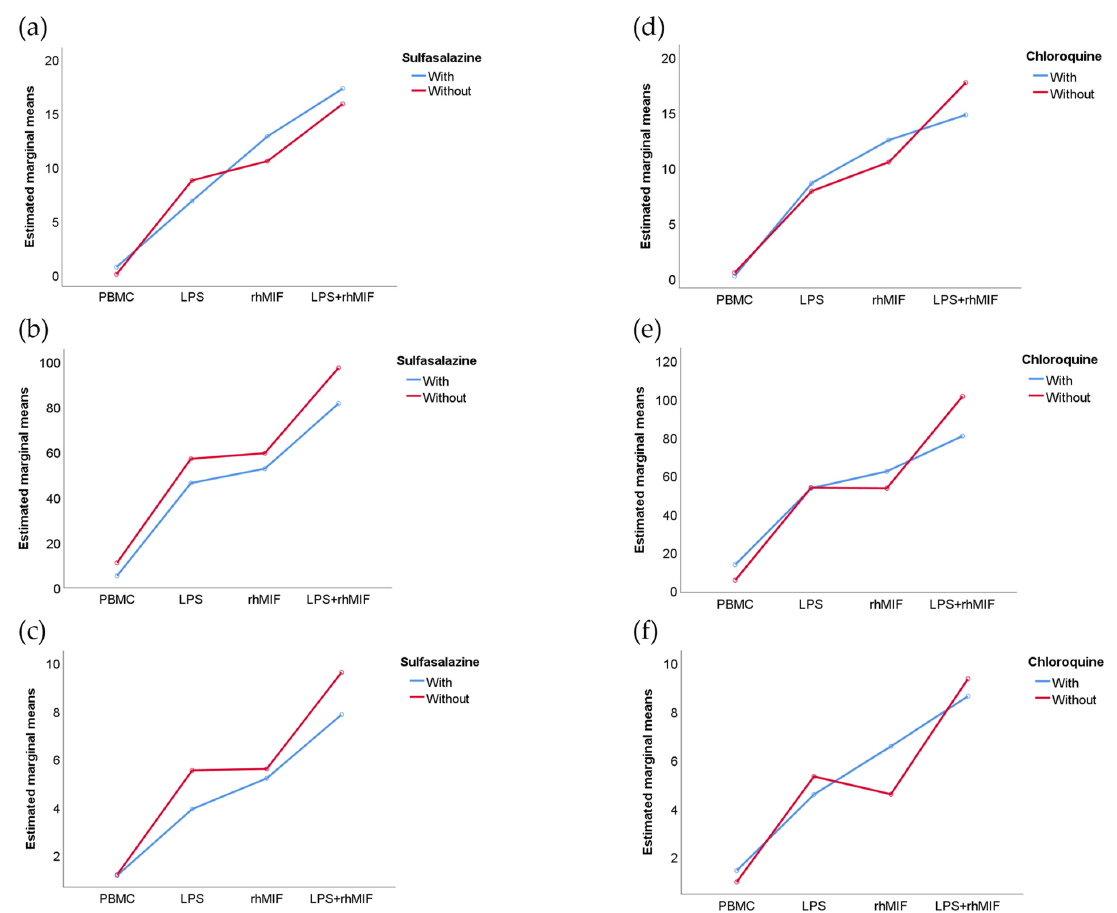
Figure 3. Interactions between the effect of stimuli and used of sulfasalazine ( a – c ) or chloroquine ( d – f ) treatments on the secretion of IL-25, IL-31, and IL-33 in supernatants of PBMC from RA patients after 24 h of stimulation with LPS and rhMIF. In the graphs, the blue line (With) refers to consuming the drug by RA patients and the red line (Without) refers to not consuming the drug evaluated as a factor. No effect of the type of stimulus or different treatments on the secretion of the IL-25, IL-31, and IL-33 was found. Data provided in estimated marginal means. Statistical analysis was performed using the two-way ANOVA followed by Tukey post hoc test.